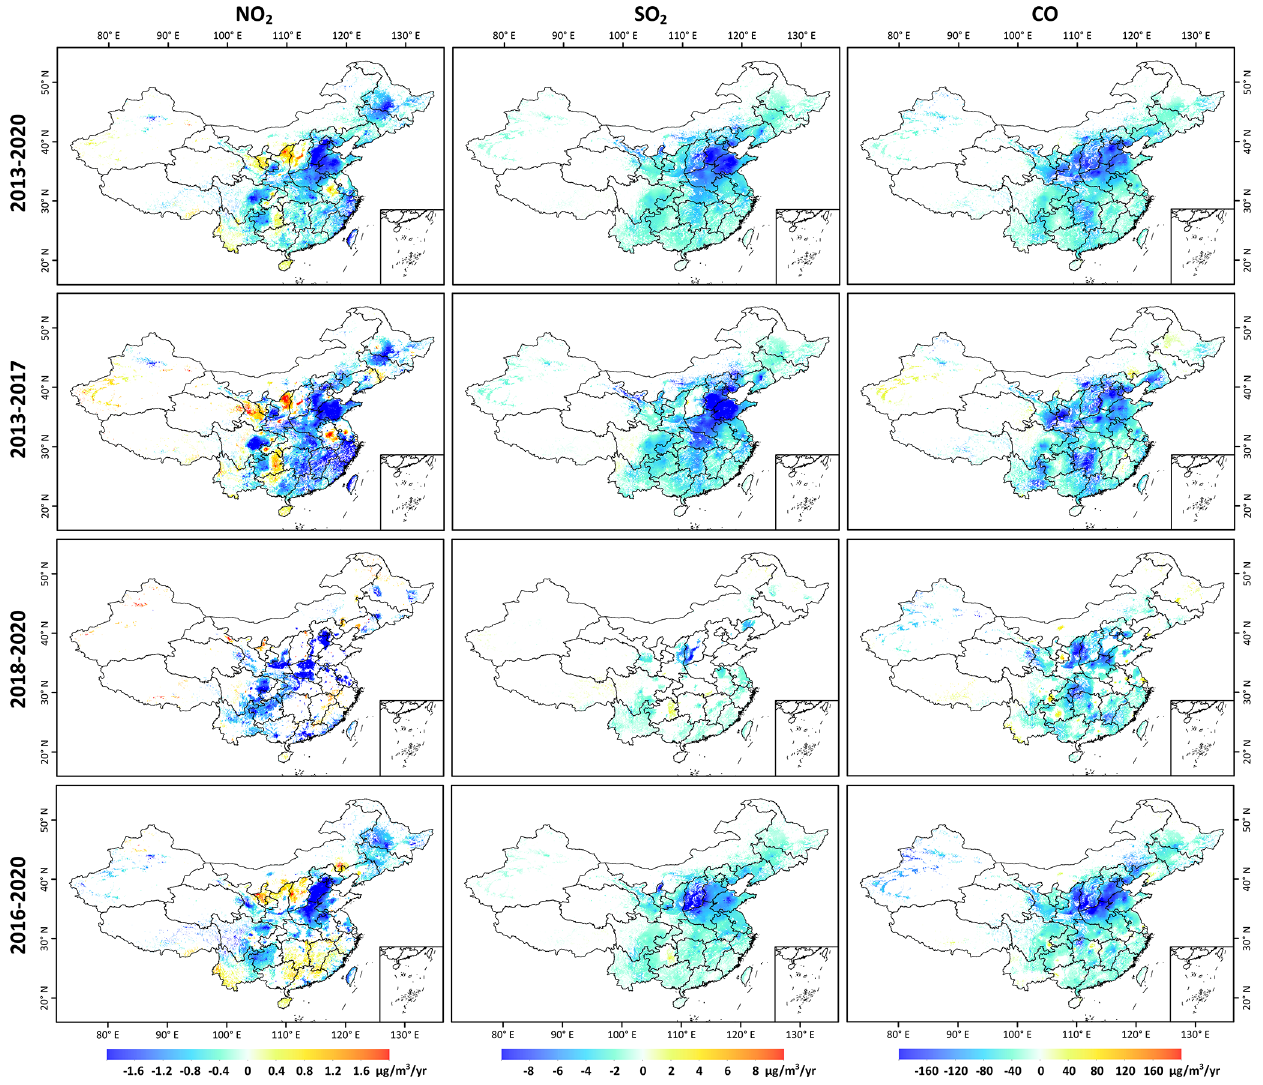
Figure 7. Temporal trends of surface NO 2 , SO 2 , and CO concentrations during the whole period (2013–2020), the Clean Air Action Plan (2013–2017), the Blue Sky Defense War (2018–2020), and the 13th Five-Year Plan (2016–2020) in populated areas of China. Only regions with trends that are significant at the 95% ( p < 0.05) confidence level are